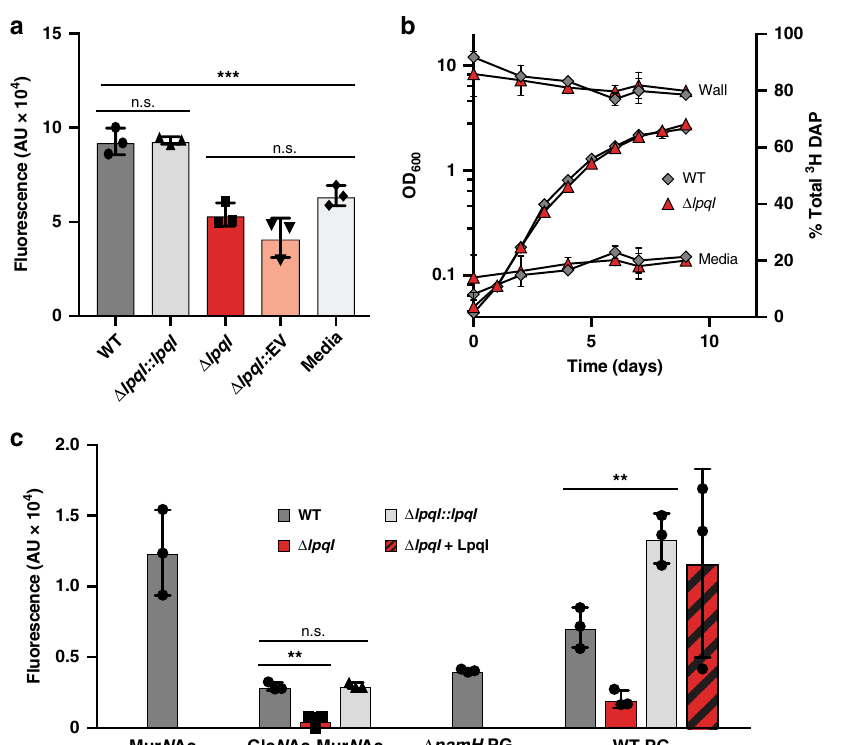
Fig. 4 M. bovis BCG is able to recycle PG. a M. bovis BCG WT, Δ lpqI , Δ lpqI :: lpqI and Δ lpqI ::Empty Vector were incubated with 1 mM 4MU-Glc N Ac in minimal media. After 3 days the fl uorescence of the cultures were measured ( n = 3; error bars are ± SD). b M. bovis BCG WT (grey diamonds) and Δ lpqI (red triangles) were simultaneously evaluated for release of cell wall peptides and growth ( n = 3; error bars are ± SD). c M. bovis BCG WT (dark grey bars), Δ lpqI (red bars), and Δ lpqI :: lpqI (light grey bars) were evaluated for their growth using Mur N Ac (5 mM), Glc N Ac-Mur N Ac (2 mM), soluble PG from M. smegmatis mc 2 155 wild-type or Δ namH (5 and 2.5 mM, respectively), and soluble PG, which had been pre-digested wth LpqI (striped bars) as sole carbon sources using a resazurin assay ( n = 3; *** = p < 0.001; ** = p < 0.005). Statistical signi fi cance determined using a two-tailed t -test in GraphPad Prism